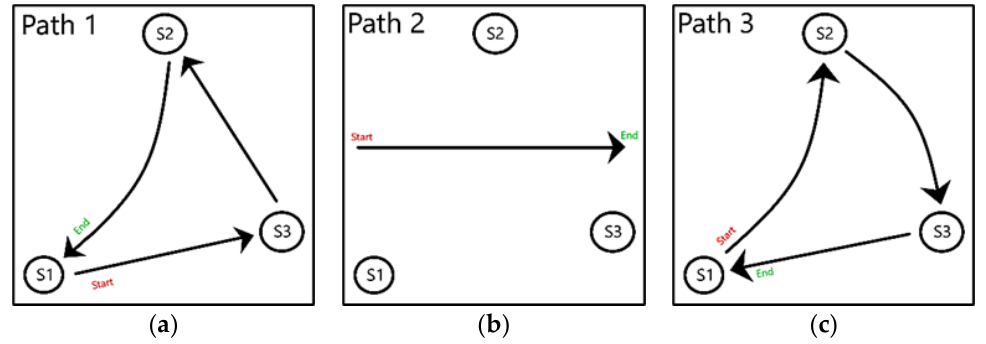
Figure 3. Different actual paths taken by the mobile device in the indoor space. (a) Path from S1 back to S1 through S3 and S2; (b) Path between the stationary devices; (c) Path from S1 back to S1 through S2 and S3.